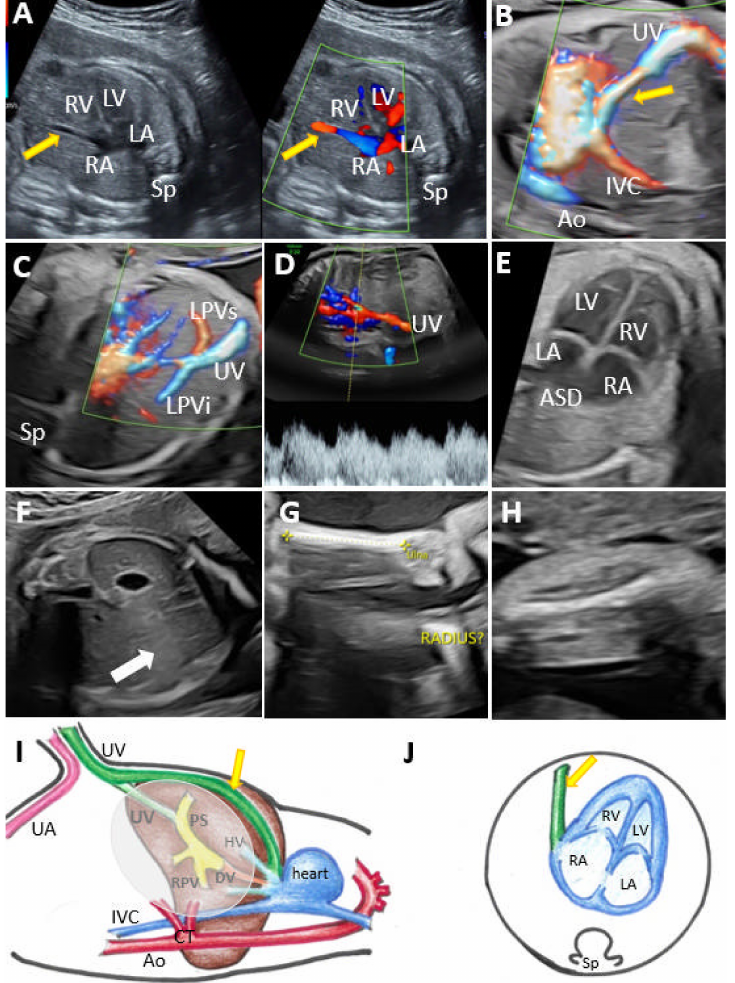
Figure 3. UPSVS type I with cardiac drainage of the umbilical vein at 24 weeks of gestation (Case 3). ( A ) Umbilical drainage (yellow arrow) directly to the right atrium visible in an axial–oblique plane of the upper abdomen and low thorax region, using duplex (color Doppler and gray-scale) imaging. ( B ) Directional power Doppler applied in the sagittal plane of the upper abdomen and low thorax region, showing the umbilical vein abnormal connection to the right atrium and absence of the ductus venosus. ( C ) Oblique plane at the abdomen level showing the absence of right portal vein. ( D ) Typical triphasic aspect of the shunt. ( E ) Four-chamber view, which demonstrates the absence of septum secundum. ( F ) The axial abdominal sweep could not find the gallbladder (white arrow). ( G ) Two- dimensional evaluation showing unilateral absence of the radius. ( H ) Short humerus. ( I , J ) Schematic diagram of type I shunt. ( I ) Sagittal plane with normal course of umbilical–portal–DV complex and hepatic veins observed by the transparency of the oval and also the abnormal course of the umbilical vein draining into the right atrium. ( J ) Four-chamber view, which demonstrates the abnormal drainage of the umbilical vein. IVC, inferior vena cava; Sp, spine; RA, right atrium; LA, left atrium; RV, right ventricle; LV, left ventricle; LPVs, the superior branch of the left portal vein; LPVi, the inferior branch of the left portal vein; ASD, atrial septal defect; UV, umbilical vein; Ao, aorta; HV, hepatic vein; PS portal sinus; RPV, right portal vein; CT, celiac trunk; DV, ductus venosus; UA, umbilical